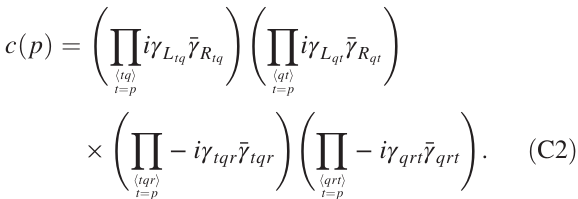
FIG. 15. The inward oriented domains consisting of h qrp i triangles are shaded in green, and the outward oriented domains consisting of h pqr i triangles are shaded in purple. The green (purple) arrows show the ordering of the product over inward (outward) oriented links in Eq. (C3). We also show one of the two Majorana operators associated with each h qpr i triangle, and relabeled it with the subscript d that labels inward pointing domains in order to make subsequent notation convenient. The reason for only showing one of the two Majorana operators is that the one we show is the only one that enters into the computation of c ð p Þ